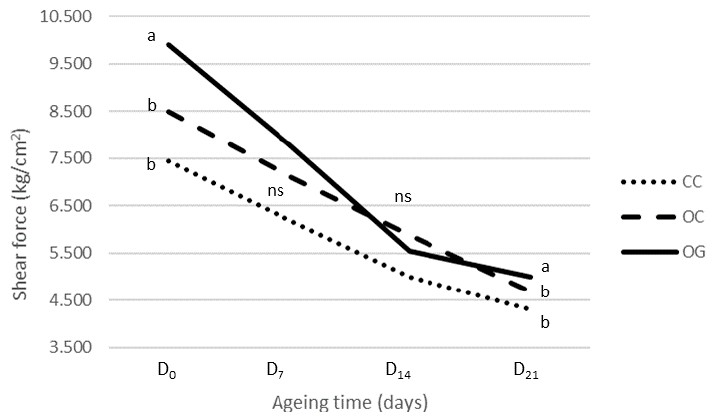
Figure 1. Evolution of the shear force values of Longissimus thoracis muscle from calves of the Retinta breed throughout 21 post-mortem days of ageing in organic grazing (OG), organic concentrate (OC), and conventional concentrate (CC) systems. Values with the same letters (a, b) indicate homogeneous subsets between productions systems for p = 0.05 according to Tukey’s HSD test; ns = not significant.